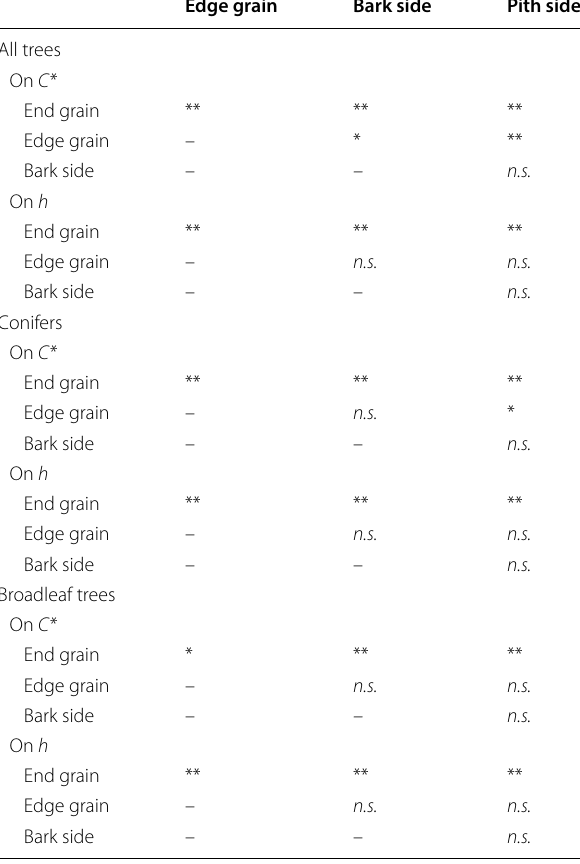
Table 6 Paired t test results of differences between each measuring plane on C* , h in Fig. 6